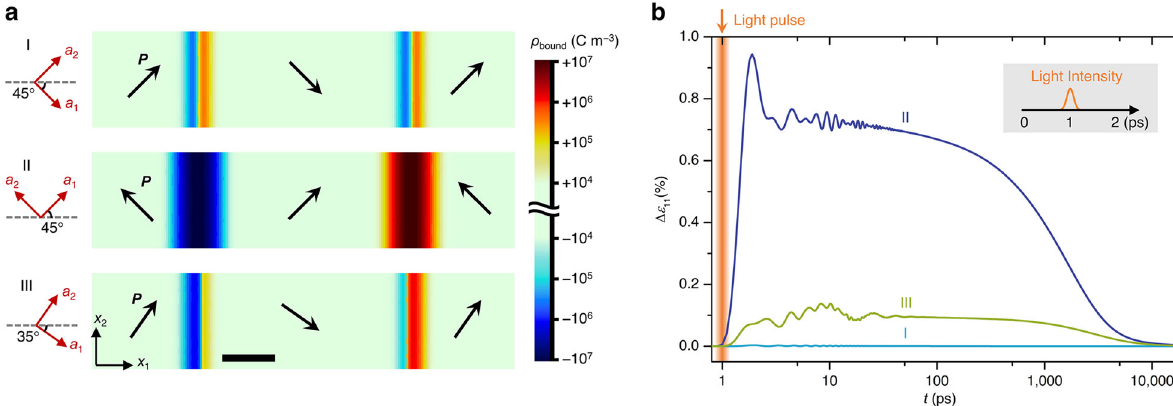
Fig. 3 Types of 90° twin domains and their light-excited strain dynamics. a Three types of 90° a 1 - a 2 twin domain structures, including (top panel, I) uncharged head-to-tail domain walls, (middle panel, II) a pair of head-to-head and tail-to-tail domain walls, and (bottom panel, III) charged tilted head-to-tail domain walls, possess different spatial patterns of bound charge densities ρ bound . Polariza- tion directions within each domain (black arrows) as well as crystallographic axes a 1 and a 2 (red arrows) and their angles to the